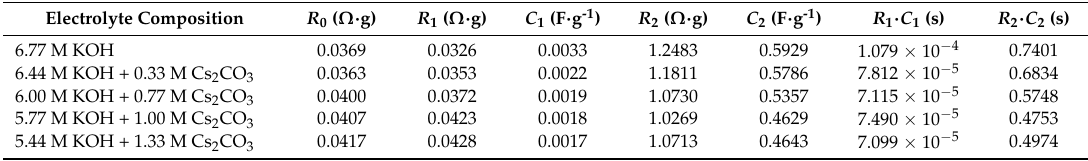
Figure 7. Proposed equivalent circuit model for NiMH batteries using Mg-based anodes [63]. Table 7. Data obtained by the AC impedance measurements of AR3 cycled in five different electrolytes. Electrolyte